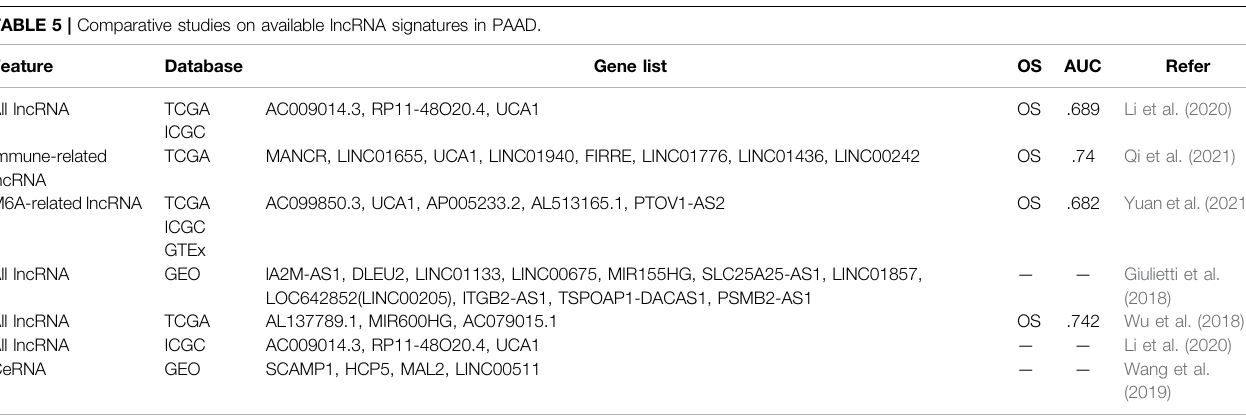
TABLE 5 | Comparative studies on available lncRNA signatures in